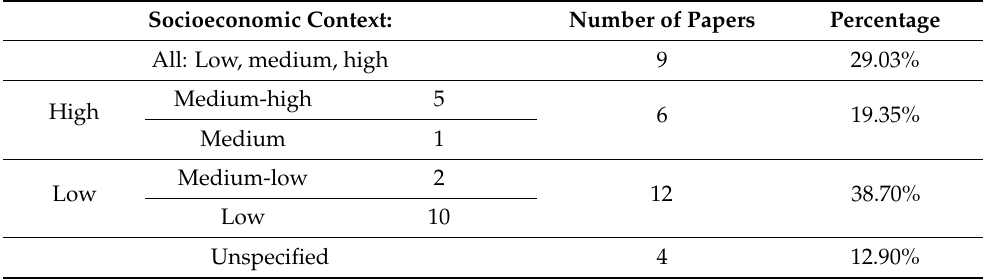
Table 4. Socioeconomic context.